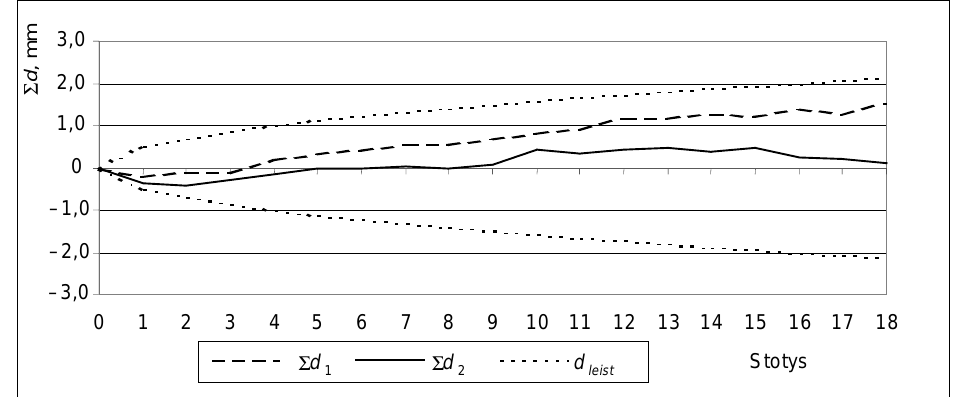
Fig 2. Accumulation of heights differences incoincidences of the experimental